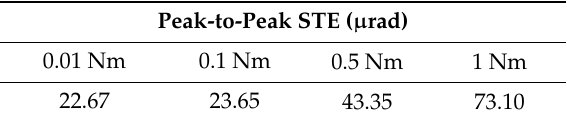
Table 2. Calculated peak-to-peak values under di ff erent loading conditions.